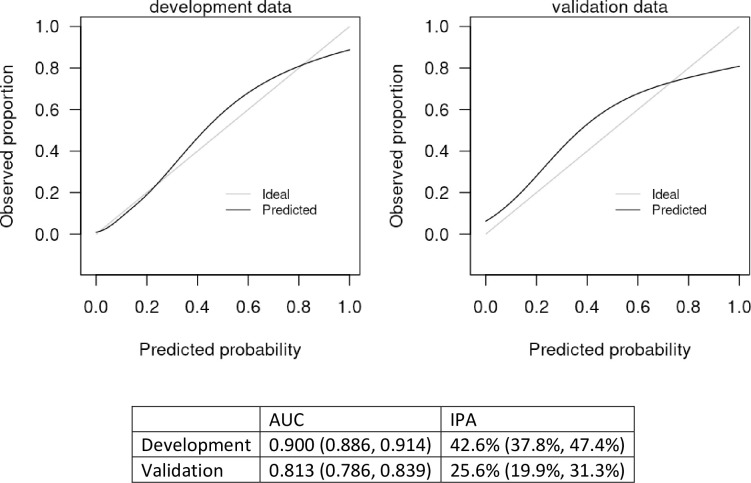
Calibration curve for the model predicting likelihood of hospitalization.The x-axis displays the predicted probabilities generated by the statistical model and the y-axis shows the fraction of the patients with COVID-19 who were hospitalized at the given predicted probability. The 45° line, therefore, indicates perfect calibration where, for example, at a predicted probability of 0.2 is associated with an actual observed proportion of 0.2. The solid black line indicates the model’s relationship with the outcome. The closer the line is to the 45-degree line, the closer the model’s predicted probability is to the actual proportion. As demonstrated, there is excellent correspondence between the predicted probability of a positive test and the observed frequency of hospitalization in COVID-19 (+) patients.